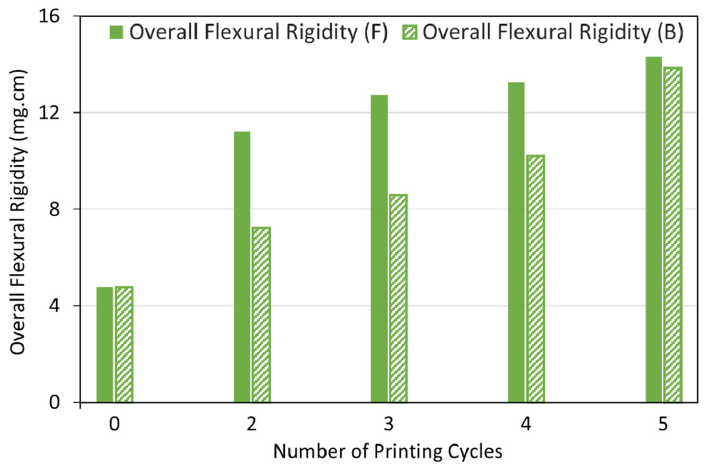
Figure 11. Overall flexural rigidity of the face (F) and back (B) side of the metallised textiles printed with the Cu–Ag NP catalyst at different numbers of cycles.